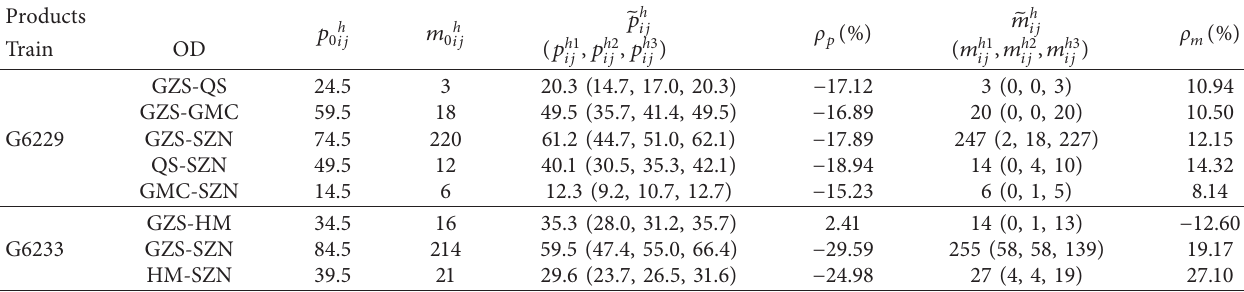
Table 5: The comparison of price and number of allocated seats before and after